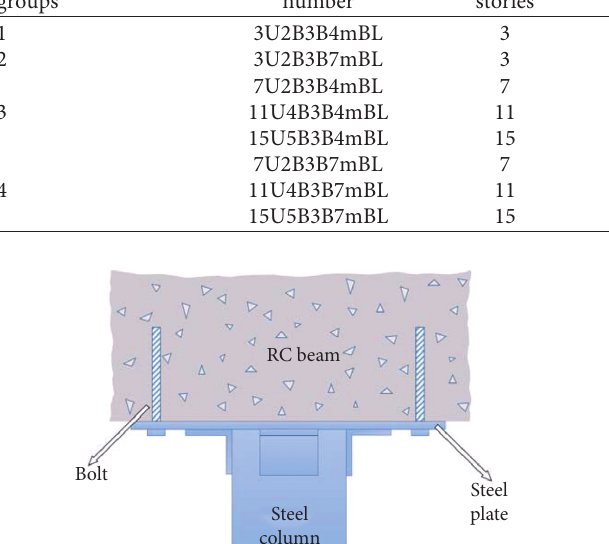
Table 1: Archetype’s configuration development and design properties for SBCC and RBCC archetypes. No. of performance groups